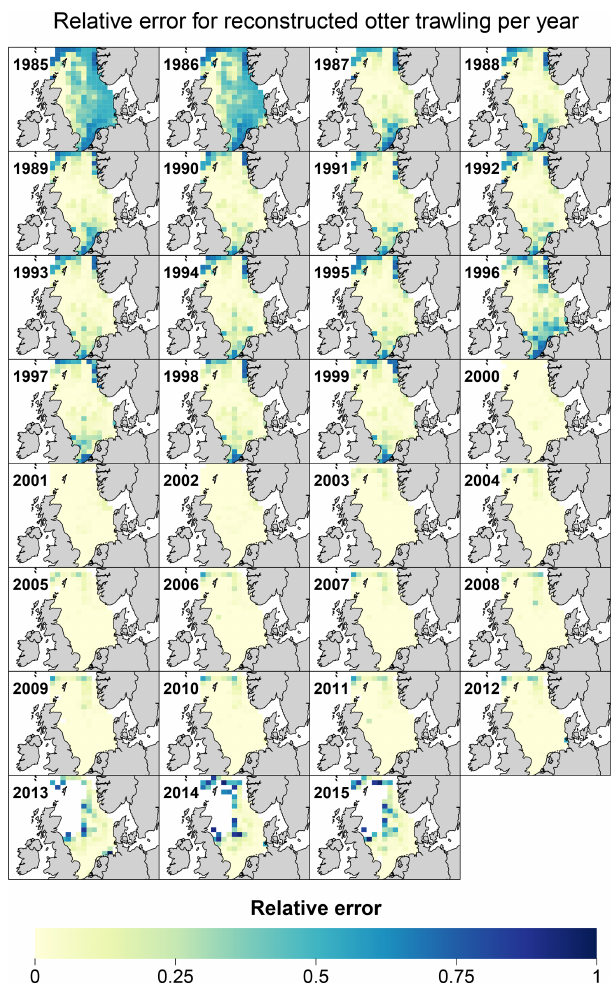
Figure 6. Spatial distribution of relative error of the reconstructed otter trawling effort (i.e. the ratio between the error of the estimated effort and the total reconstructed effort) per ICES rectangle in the North Sea in